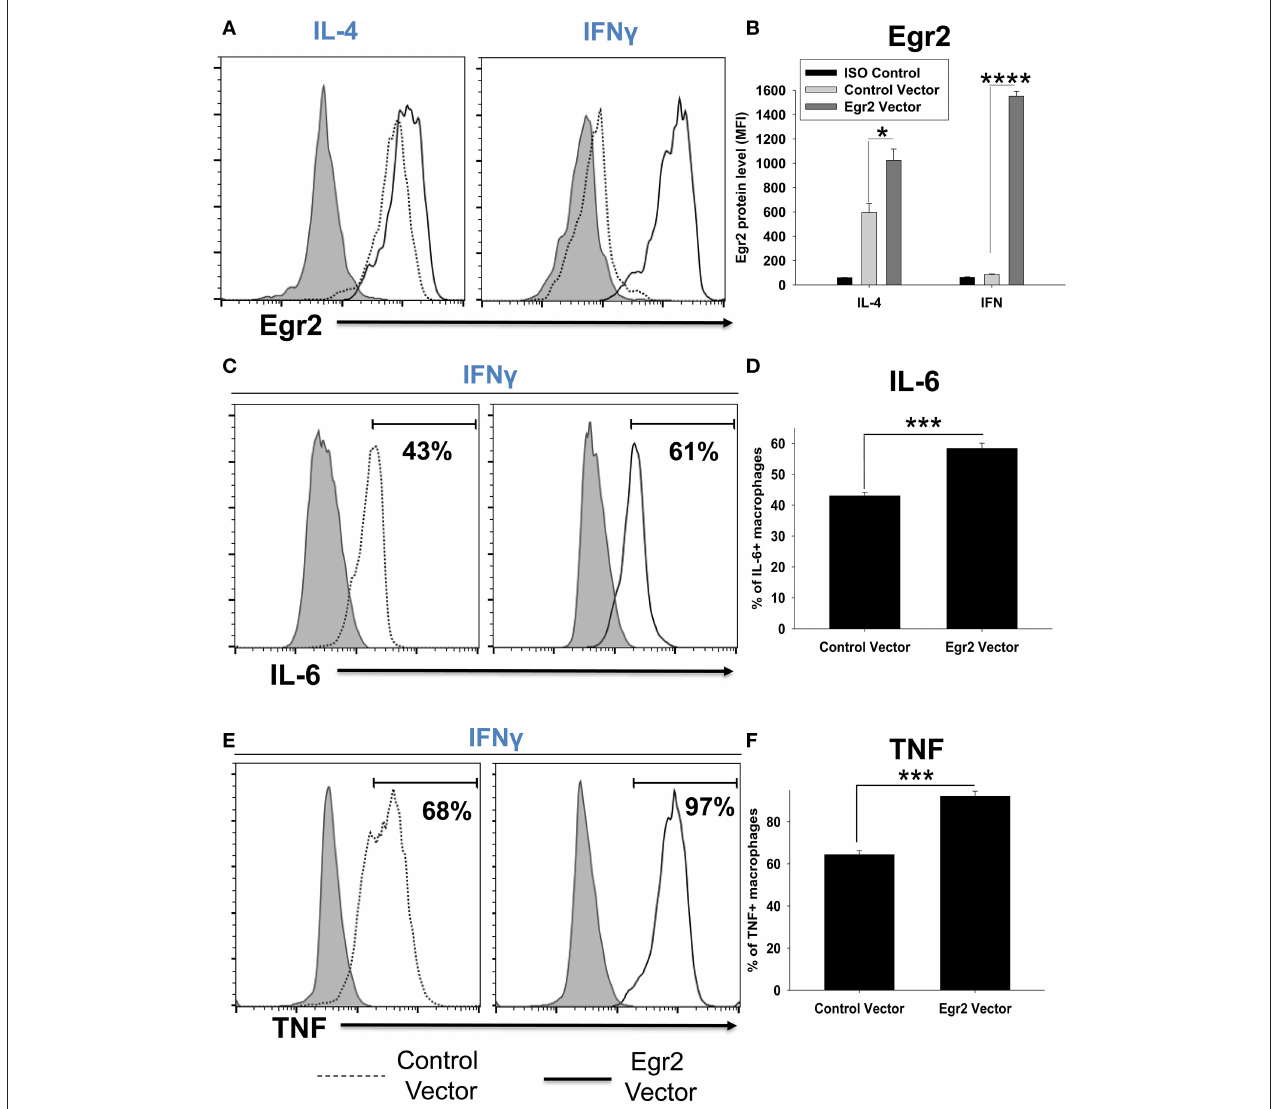
FIGURE 11 | Analysis of expression of Egr2, IL-6, and TNF on a protein level in activated macrophage cell line with overexpression of Egr2. Macrophage cell line RAW264.7 was transfected with empty (control) pMIG plasmid vector (Control Vector), or vector with Egr2 (Egr2 Vector) for 24h and after which the cells were activated with IL-4 or IFN γ for another 24 h-time period as in Figure 10 . The cells were washed, fixed/permeabilized and stained for intracellular Egr2, IL-6, or TNF with fluorescently labeled mAbs as described in Materials and Methods . GFP + gated transfected cells were analyzed for expression of Egr2, IL-6, or TNF by three-color flow cytometry. Expression of Egr2 (A,B) , IL-6 (C,D) and TNF (E,F) in cells transfected with Egr2 Vector (solid line) vs. Control Vector (dotted line) are shown on representative histogram graphs (A,C,D) . Staining with isotype-matched control mAbs is shown by shaded histograms. Quantitative analysis (mean fluorescence intensity level for Egr2 and percentage of positive cells for IL-6 and TNF) is shown in (B,D,F) . In (B,D,E) , mean ± S.E. of six separate culture plate wells is shown. Statistically significant differences in the expression levels are shown on each figure (* p < 0.05; *** p < 0.001; **** p < 0.0001).